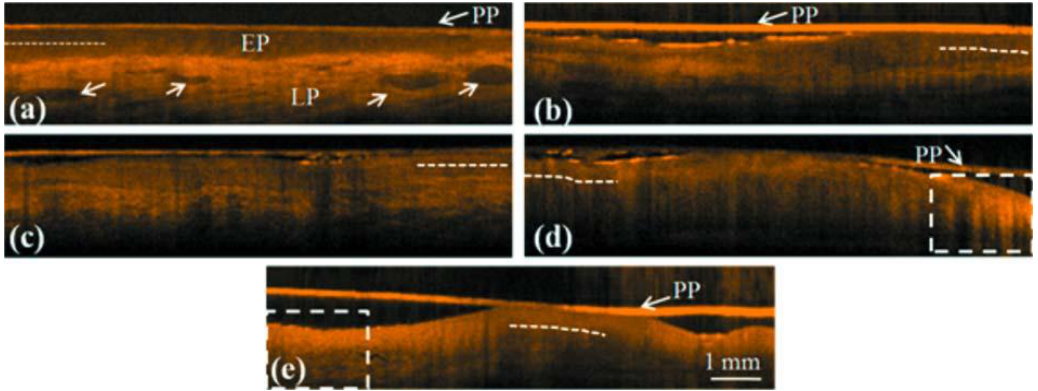
Figure 14. SS-OCT scanned images of the ( a ) normal control and biopsied oral ( b ) MiD, ( c ) MoD, ( d ) ES-SCC, and ( e ) WD-SCC lesions. Their histological images were shown in Figure 13(a–e) (reprinted from reference